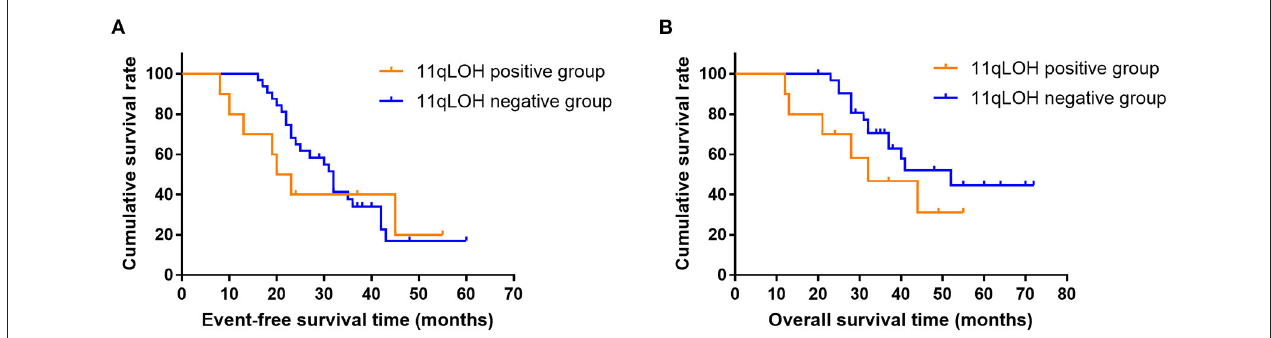
FIGURE 1 | Event-free survival (A) and overall survival curves (B) for patients with MYCN amplification plus 11qLOH ( n = 14) and MYCN amplification alone ( n = 28).